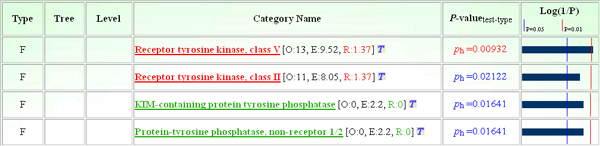
GFINDer Statistics Protein Familes&Domains module: protein family analysis. InterPro protein families most significantly over- (red) and under-represented (green) in the considered tyrosine kinase versus tyrosine phosphatase gene classes; Type: type of InterPro entry (F: protein family); Tree: tree label in the defined protein family parent/child hierarchy, if any; Level: level in the related tree of the defined protein family parent/child hierarchy, if any (higher levels correspond to more specific protein families); P-valuetest-type: p value defining relevance of a given protein family (Category Name) for a considered class of genes, and initial of used statistical test name (h: hypergeometric distribution test).